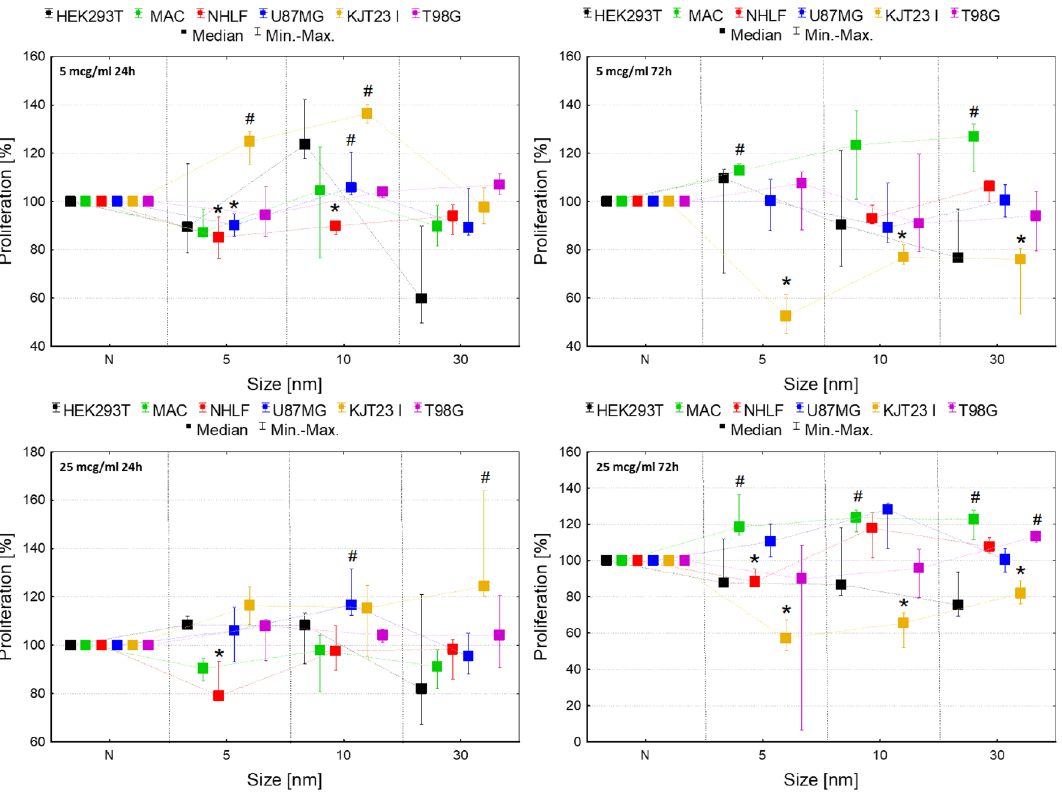
Figure 1. Normalized cell number after 24 and 72-h exposure to IONPs with core diameter of 5 nm, 10 nm and 30 nm in the concentrations of 5 µg Fe/ml and 25 µg Fe/ml comparing to the control group (N). The statistically significant ( p < 0.05) increases of cell lines proliferation level compared with corresponding N group were marked with “#” while decreases with “*”. The scales were adjusted for each chart so that data presented are the most